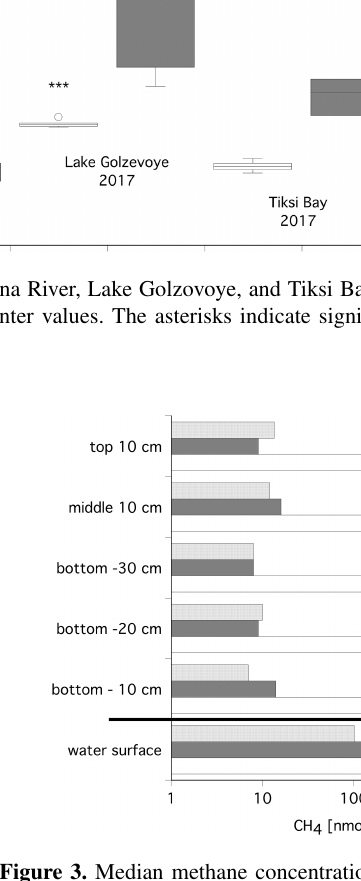
Figure 3. Median methane concentrations in the ice cores and in the water below the ice. Data from Tiksi Bay are shown in light grey and data for Lake Golzovoye in dark grey, with core no. 24 shown separately in white. Note the logarithmic